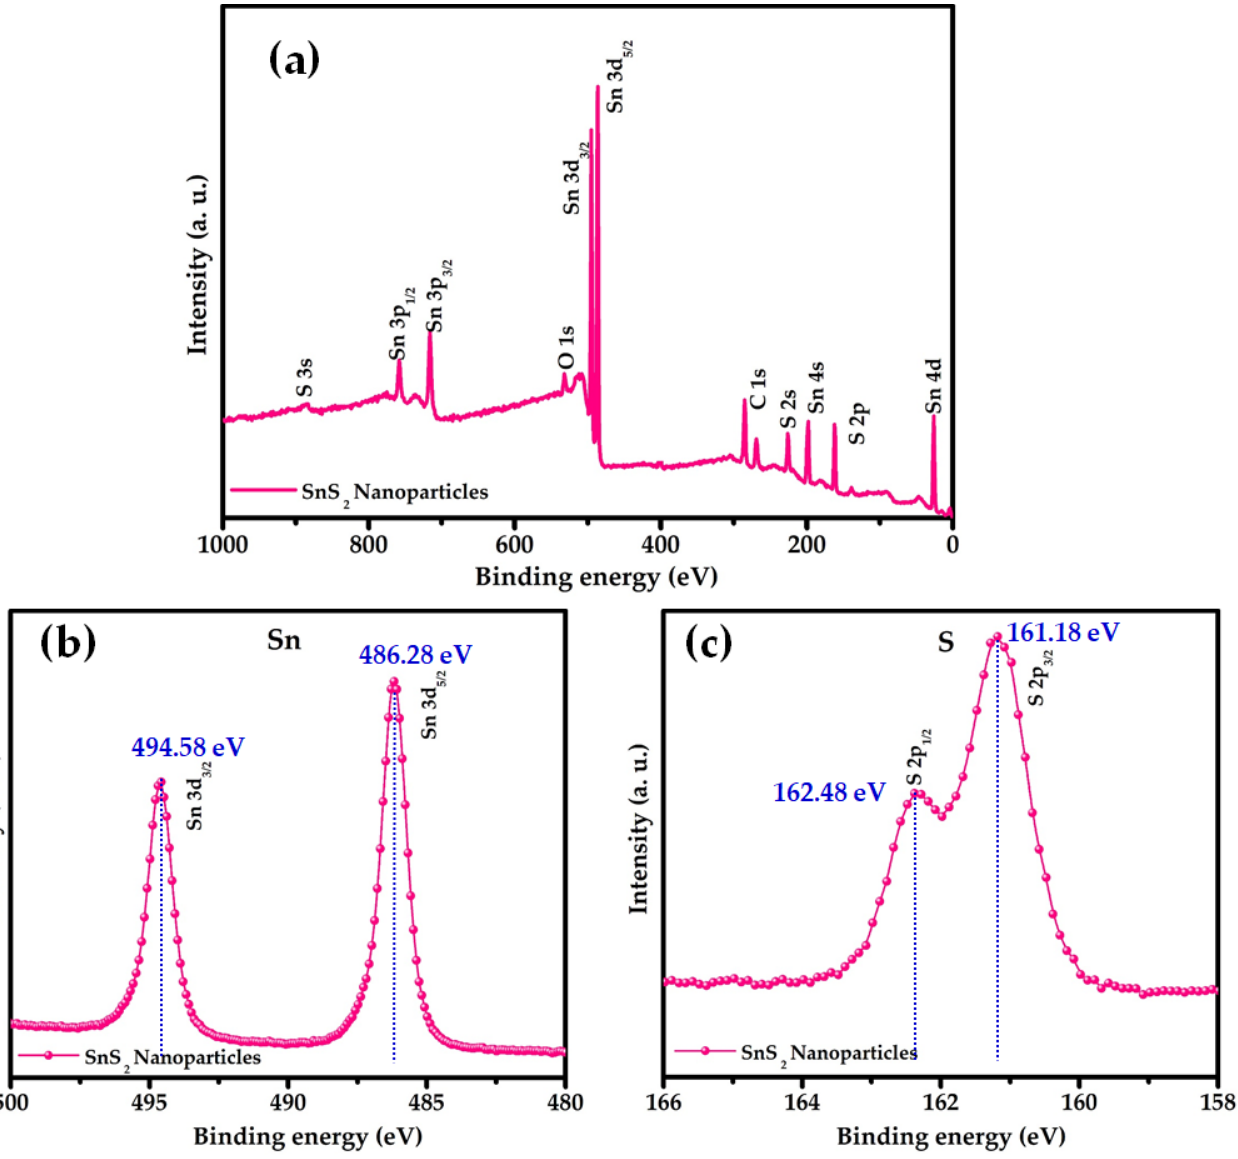
Figure 4. ( a ) Full-scan XPS spectrum and high-resolution scan of the ( b ) Sn 3d core level and ( c ) S 2p core level of SnS 2